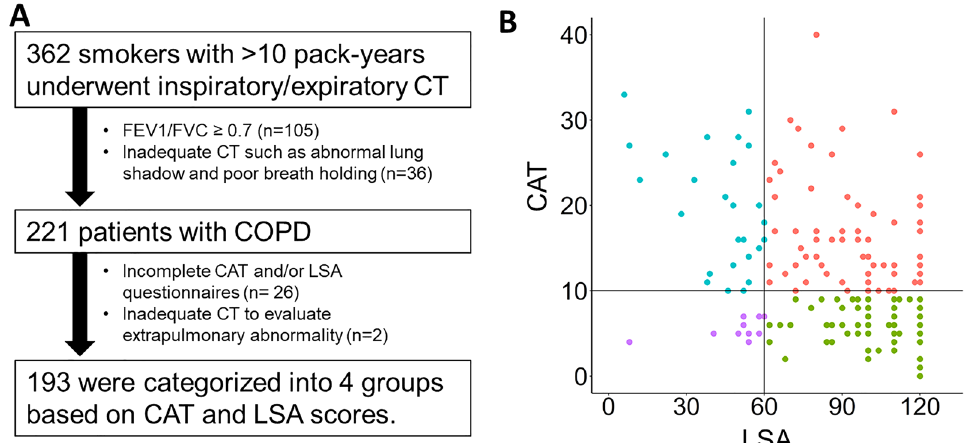
Figure 1. Patients’ flow and the distribution of COPD assessment test and Life-Space Assessment scores. Based on COPD assessment test (CAT) score of 10 and Life-Space Assessment (LSA) score of 60, patients were divided into 4 groups: (1) those with low CAT and high LSA (less symptomatic and physically active, n = 82), (2) low CAT and low LSA (less symptomatic and physically inactive, n = 11), (3) high CAT and high LSA (symptomatic and physically active, n = 73), (4) high CAT and low LSA (symptomatic and physically inactive, n =